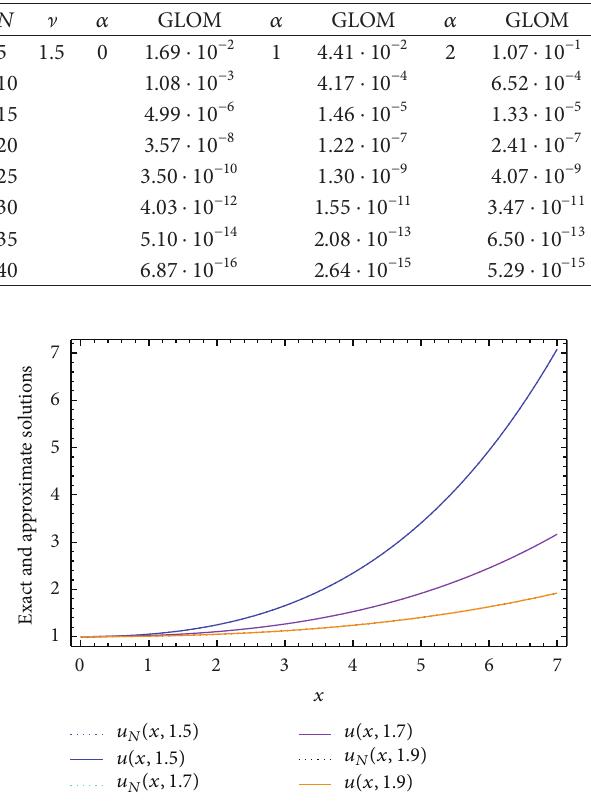
Figure 1: Comparing the exact solution and the approximate solutions at 𝑁 = 10 , 𝛼 = 1 , and ] = 1.5, 1.7, 1.9 .